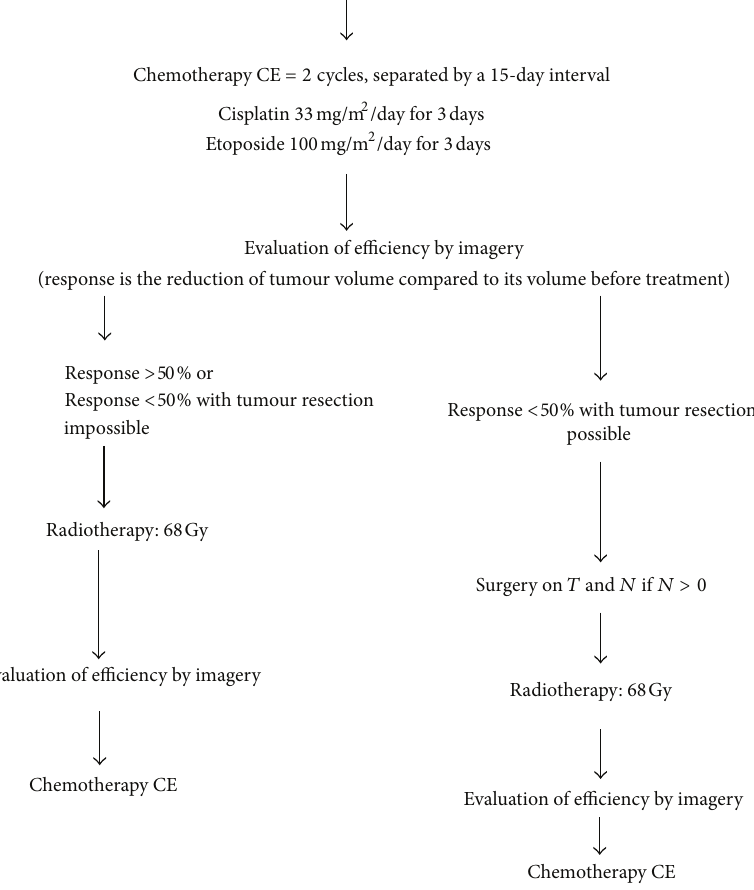
Table 1: Histological and immunohistochemical features of sinonasal tumours with neuroendocrine differentiation [4]. Histology IHC Tumor classification